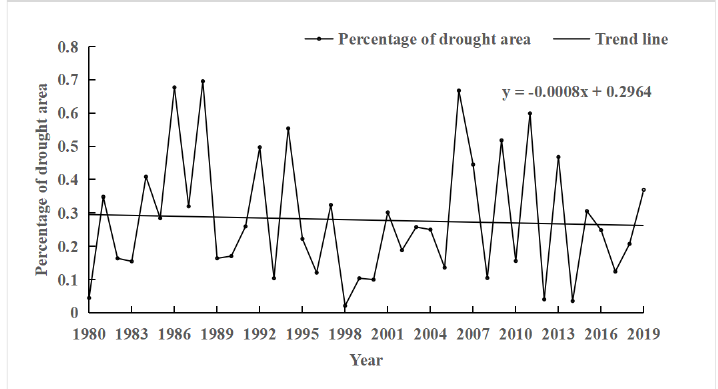
Figure 7. Percentage of drought area.